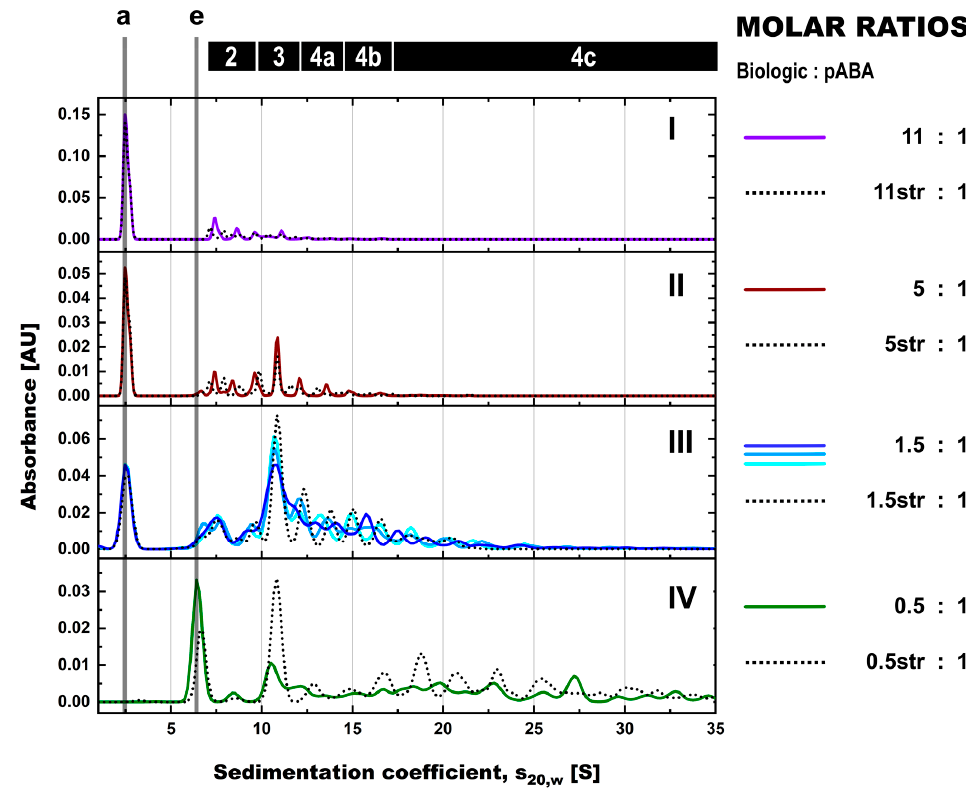
Figure 6. SV-AUC assessment: impact of biologic material degradation on formation of immune com- plexes in PBS matrix. SV-AUC profiles are shown for biologic:pABA compositions of the following molar ratios—11:1 on panel ( I ), 5:1 on panel ( II ), 1.5:1 on panel ( III ), and 0.5:1 on panel ( IV ), whereby full lines represent compositions using non-stressed biologic material (performed in triplicate for the 1.5:1 composition) and dotted lines represent compositions using stressed material. Marker: (a) free biologic, (e) free pABA, (2) immune complexes with a single ABA incorporated, (3) immune (4b) immune complexes with four incorporated ABAs, (4c) immune complexes with more than